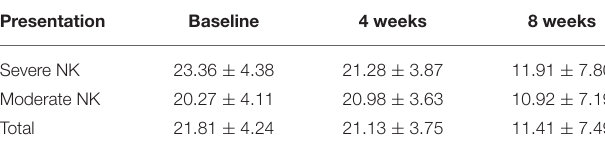
TABLE 1 | Corneal sensibility in severe and moderate neurotrophic keratitis. TABLE 2 | Visual analog scores in severe and moderate neurotrophic keratitis.